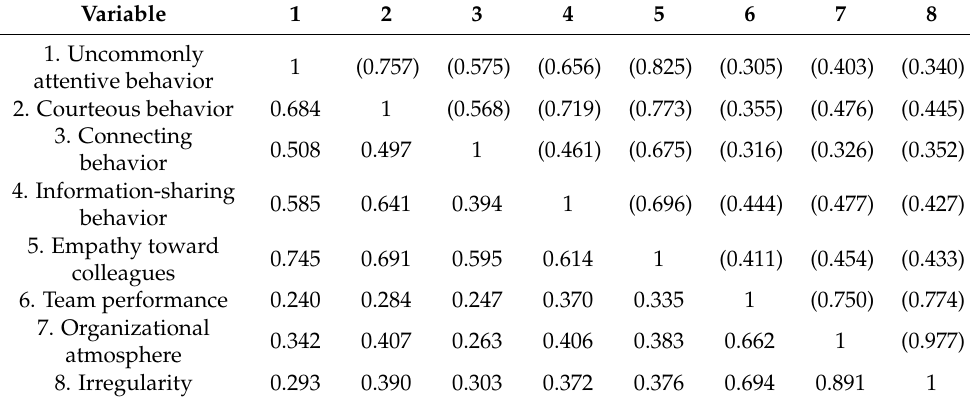
Table 3. Discriminant validity testing based on correlation coefficient confidence intervals.